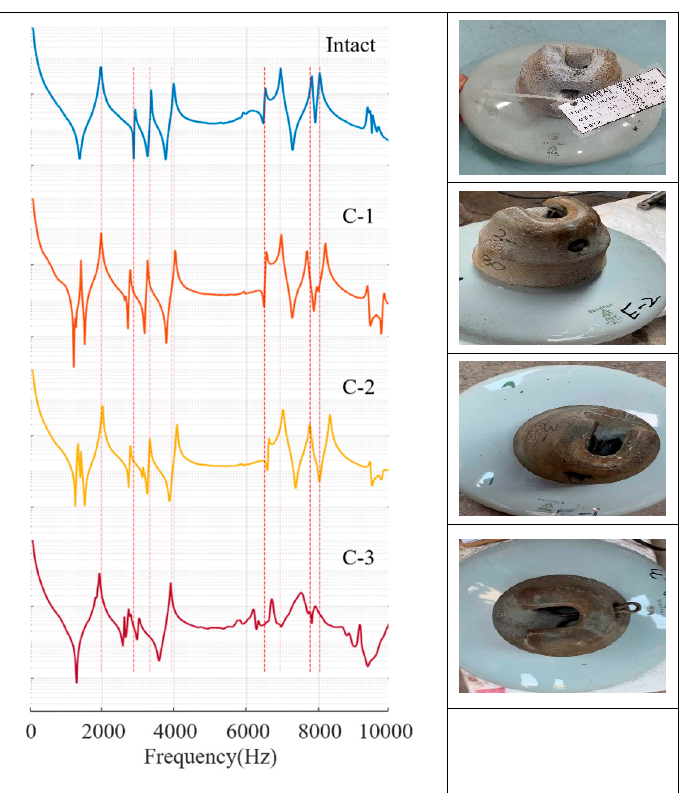
Figure 8. Internally defective samples and FRF results.